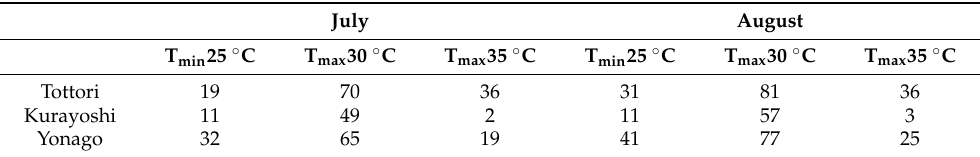
Table 2. Days with a minimum temperature of ≥ 25 ◦ C, a maximum temperature of ≥ 0 ◦ C and ≥ 35 ◦ C